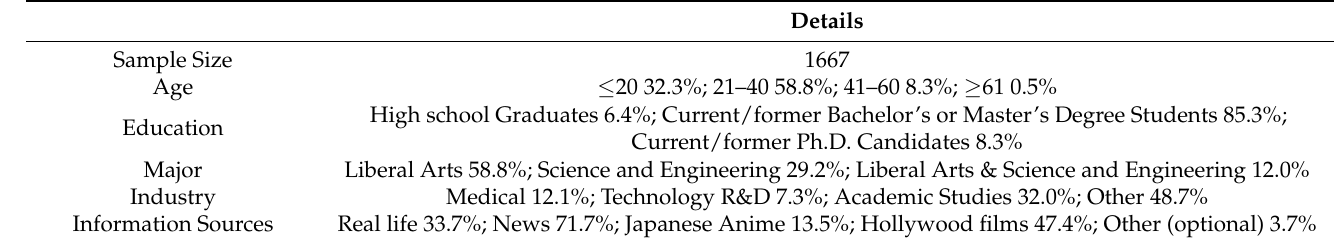
Table 1. Details of the sample